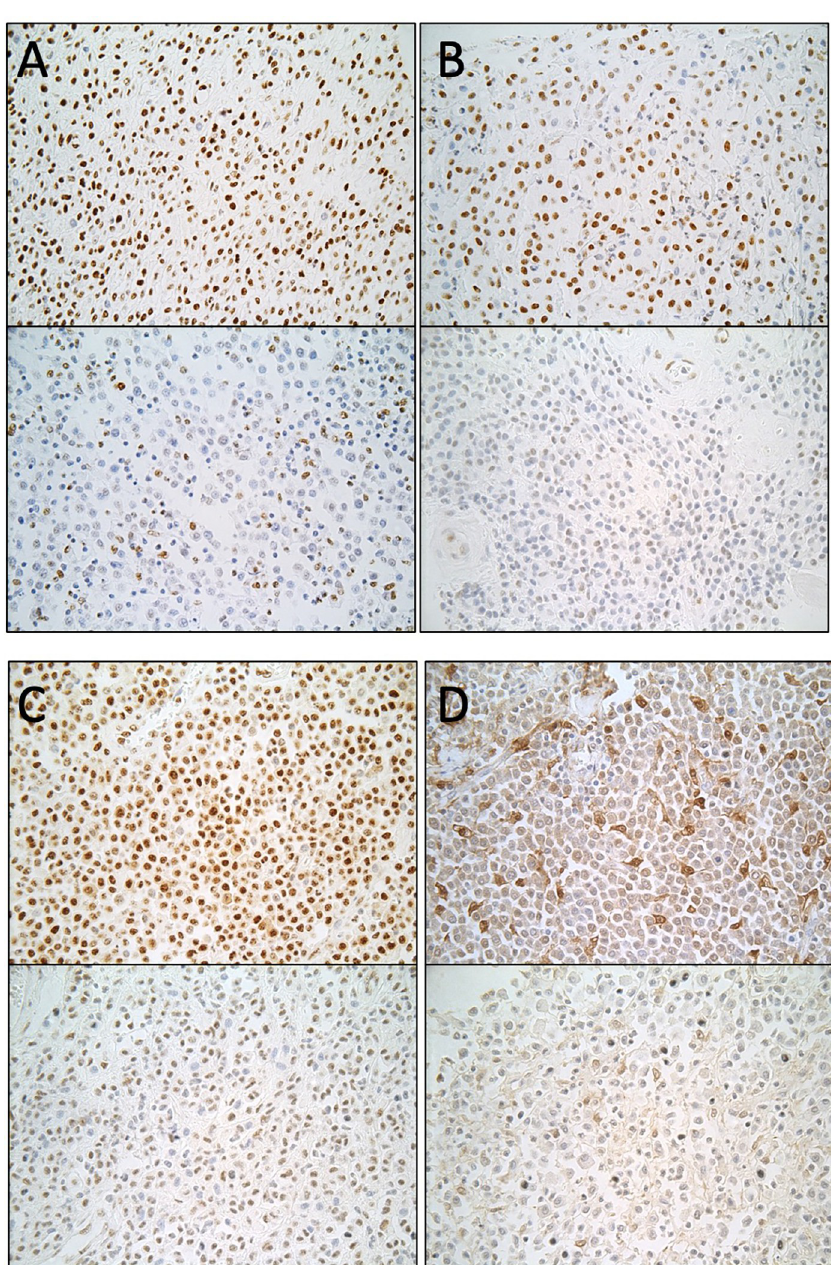
Fig 2. Brightfield images of TMA cores after immunohistochemistry and DAB detection. Top image in each pair shows an example of high H-score and bottom image of low H-score. A ) 5-methylcytosine; B ) 5- hydroxymethyl cytosine; C ) DNMT1; D ) IDH1. All images captured with 40X objective. location. A previous study found Kiupel’s grading system high grade canine MCT cases showed global hypomethylation, but that study did not evaluate case outcome [27]. In canine acute myeloid leukemia (AML), the DNA methylation profile was very heterogeneous com- pared to normal samples [28]. While neither hypermethylation nor hypomethylation alone was consistently associated with canine AML, there was both global hypermethylation in some